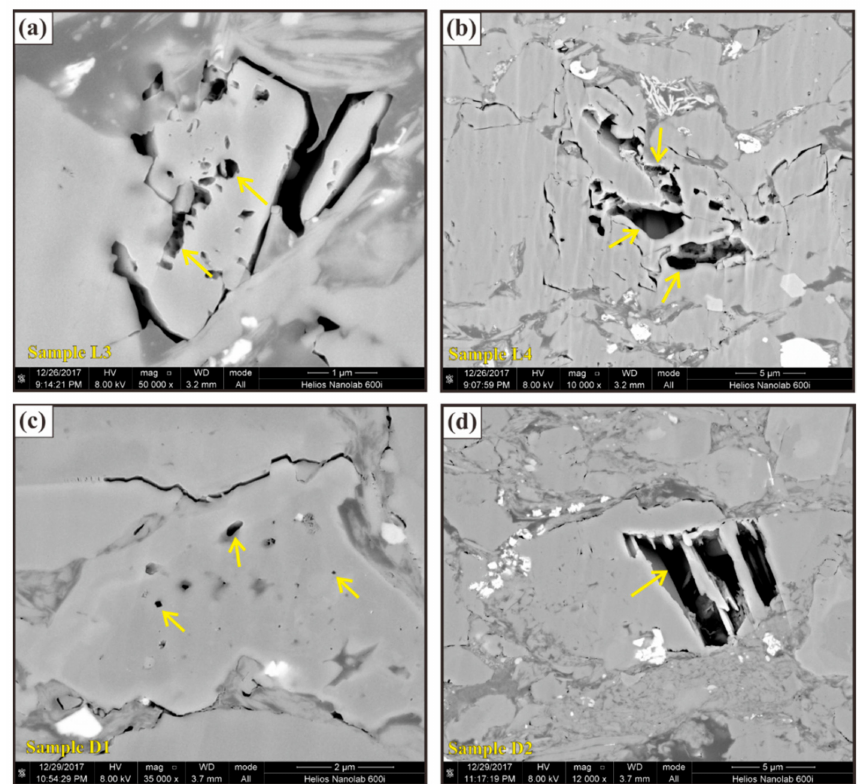
Figure 6. SEM photomicrograph images of intraparticle dissolution pores in Lujiaping deformed shales. The dissolution pores are indicated with yellow arrows. ( a ) SEM image showing abundant intraparticle dissolution pores within sample L3; ( b ) SEM image showing abundant intraparticle dissolution pores within sample L4; ( c ) SEM image showing abundant intraparticle dissolution pores within sample D1; ( d ) SEM image showing abundant intraparticle dissolution pores within sample